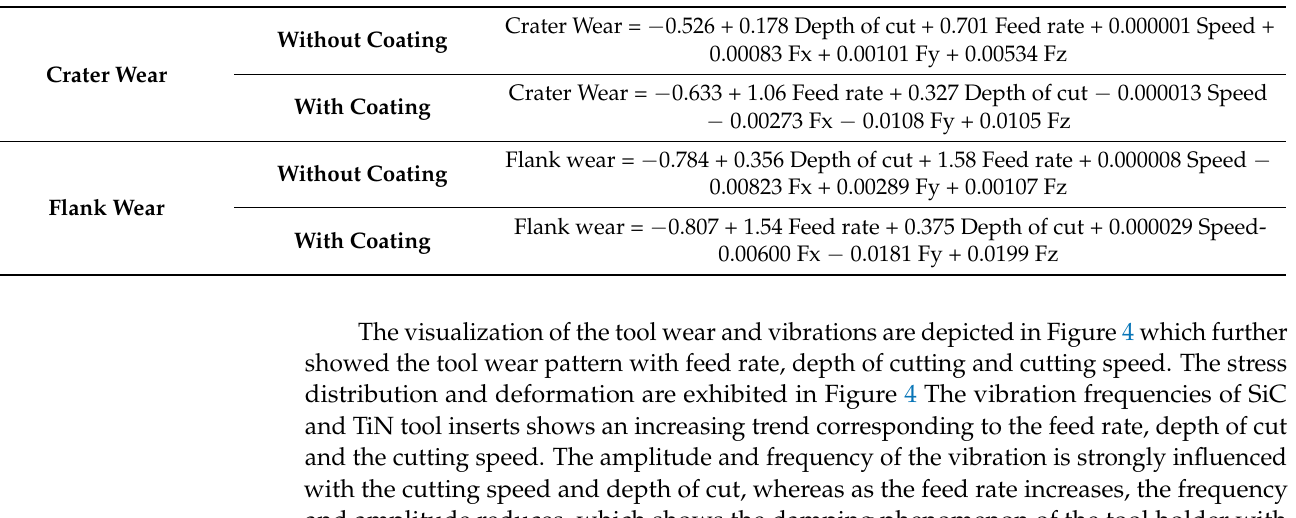
Table 5. Regression Equations for crater and flank wear.